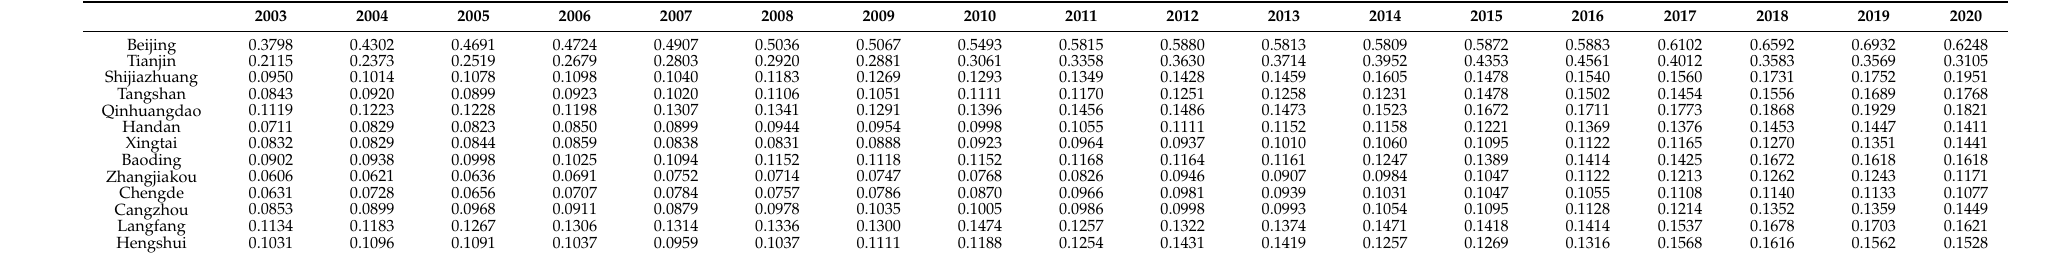
Table 2. Measurement analysis of high-quality economic development of Beijing–Tianjin–Hebei urban